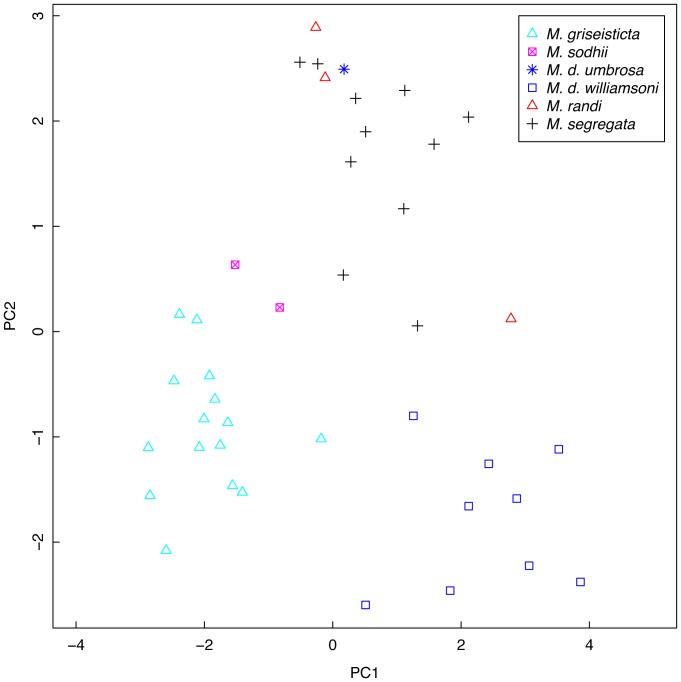
Principal components analysis of plumage scores of Asian Muscicapa taxa.Specimens were scored from 1–10 based on 13 plumage traits. See Table 6 for details.